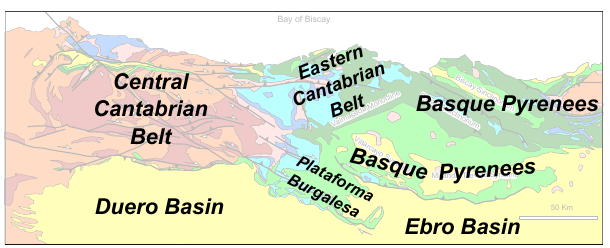
Fig. 5. Cenozoic orogenic sub-domains of the study area.